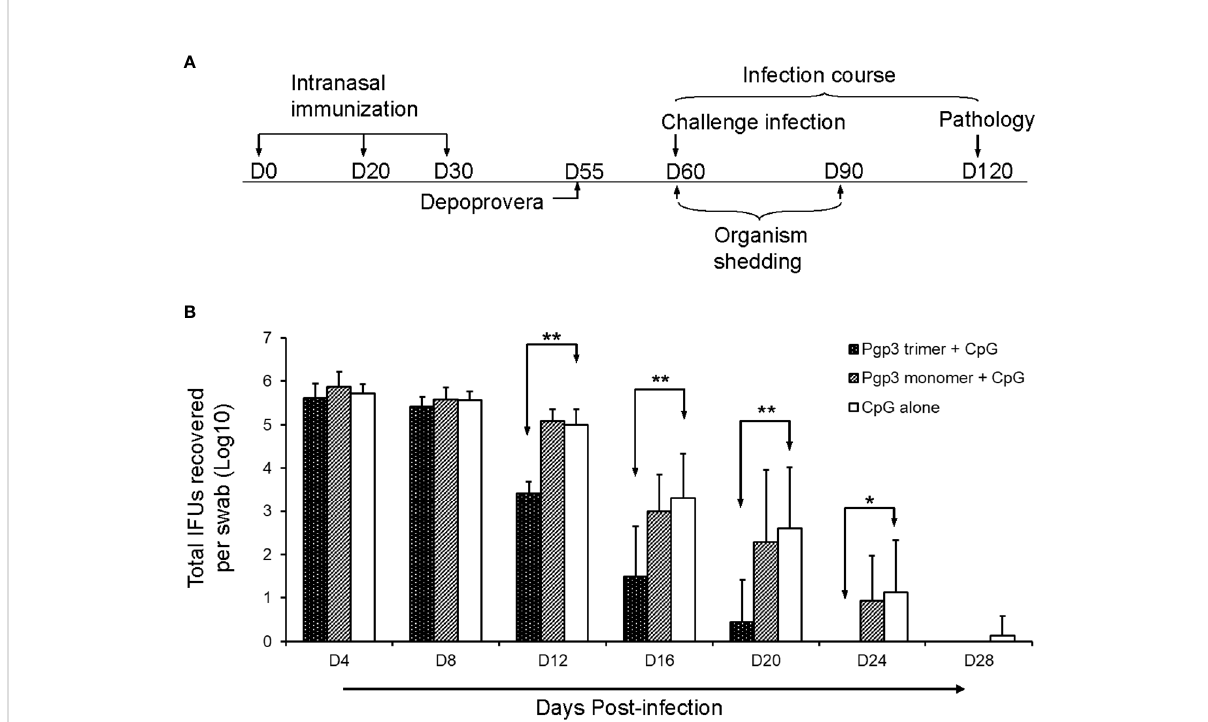
FIGURE 5 Live chlamydial organism shedding from mice vaginas following challenge. (A) For the experiment, 5-6-week-old BALB/c mice were immunized intranasally with Pgp3 trimer + CpG, Pgp3 monomer + CpG, or CpG alone on days 0, 20, and 30. In total, fi ve mice/group were sacri fi ced before the challenge to monitor speci fi c humoral and cellular immune responses. The remaining mice (n = 10) were challenged intravaginally with ( C ) muridarum , and vaginal live chlamydial organism shedding was monitored every 4 days until 28 days after infection. Day 60 post- challenge, all mice were sacri fi ced for pathological evaluation. (B) Vaginal swabs were collected for measuring IFU numbers, and each swab IFU number was converted into log 10 . The log 10 IFUs were compared between the three groups of mice at each time point using the ANOVA Test